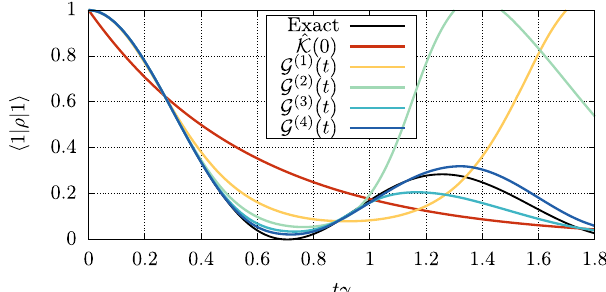
FIG. 4. Jaynes-Cummings model, underdamped regime. Decay of the probability h 1 j ρ ð t Þj 1 i obtained from generators of the transient iteration for Γ = γ ¼ 13 and ε ¼ 20 using the starting ˆ K point ð 0 Þ .